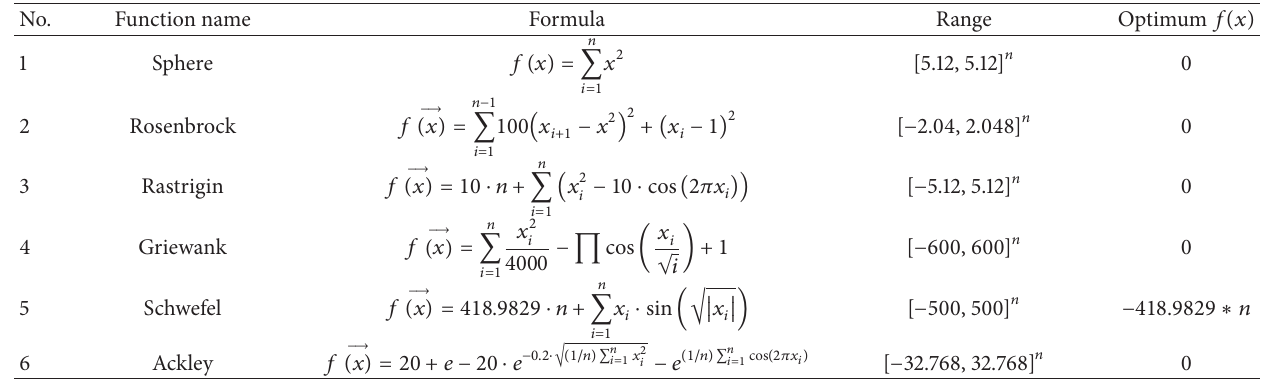
Table 1: Unconstrained test